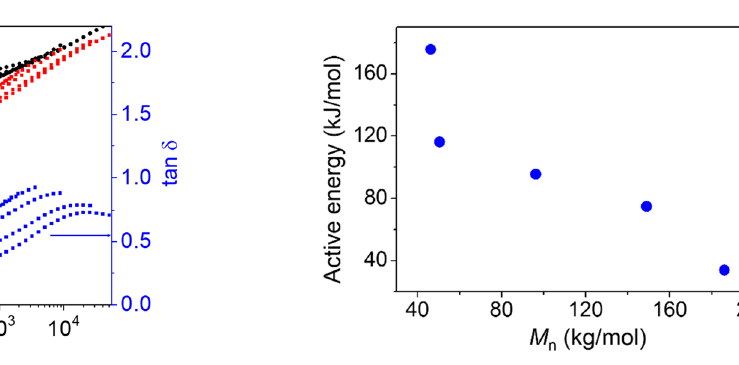
Figure A4: Master curve of ( S 15.4 - 0.28 - B 34.3 ) 3 with G ′ , G ″ , and tan δ versus angular frequency ( ω ) with the reference temperature at 150°C.